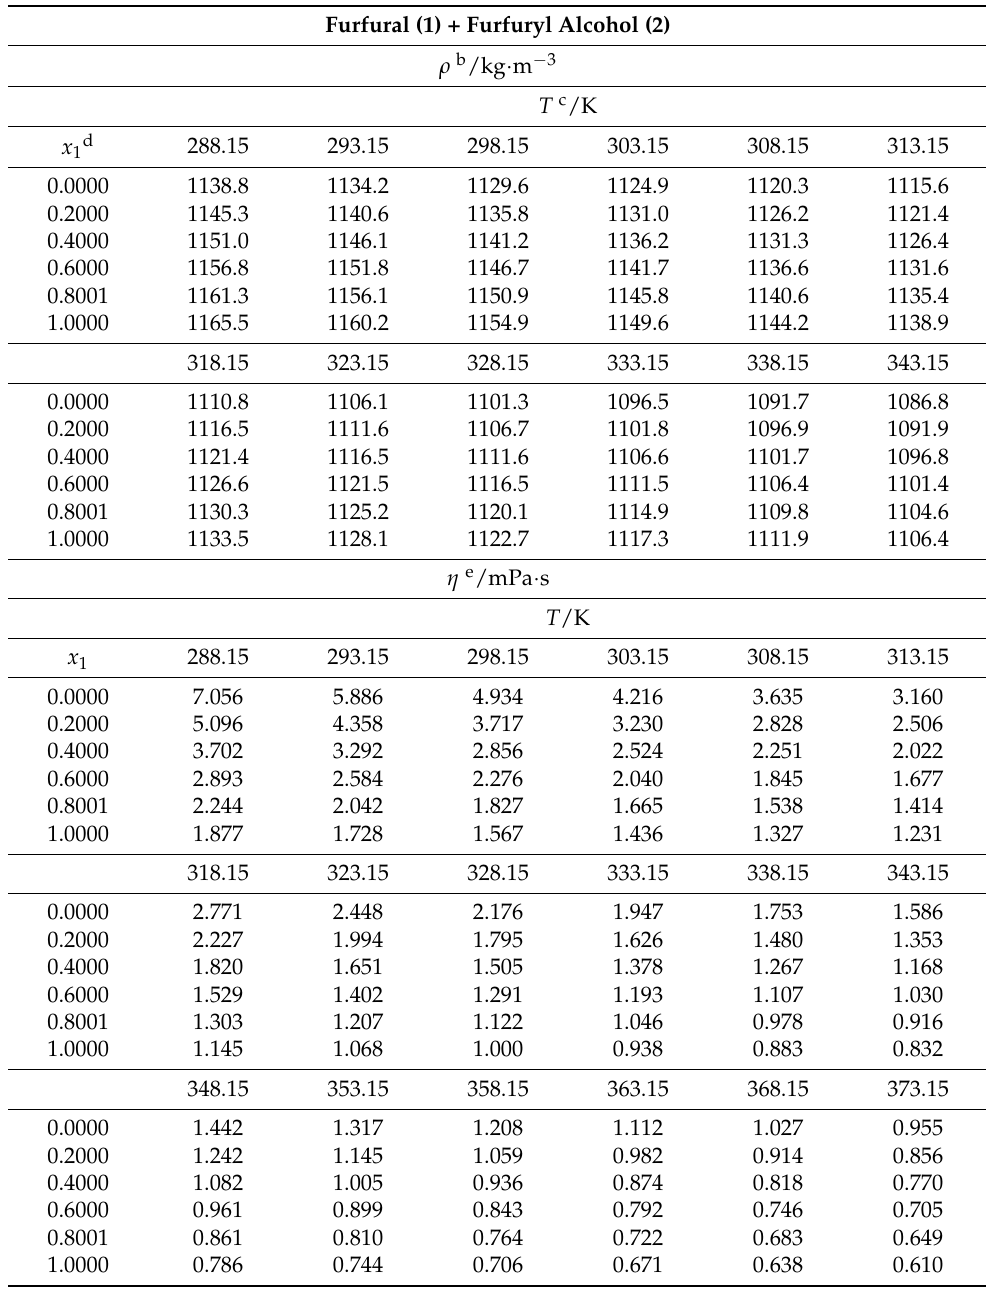
presented here with AAD of 0.07% (0.001) and 0.11% (0.002), respectively. The comparison of the measured values with the refractive index reported by Nduli and Deenadayalu [18] and Belhadj et al. [20] resulted in AAD of 0.08% (0.001) and 0.12% (0.002), respectively. Table 2. Density, ρ , dynamic viscosity, η , speed of sound, u , and refractive index, n D , of the binary system furfural (1) + furfuryl alcohol (2) as a function of furfural mole fraction, x 1 , at p = 0.1 MPa a . Furfural (1) + Furfuryl Alcohol